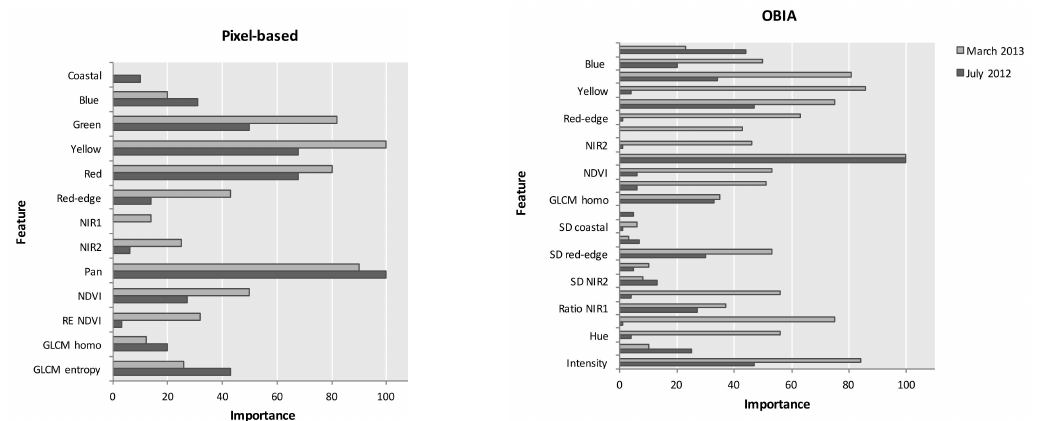
Figure 5. Plots of features importance using Random Forest classifier with pixel- and object-based approach applied to June 2012 and March 2013 images.